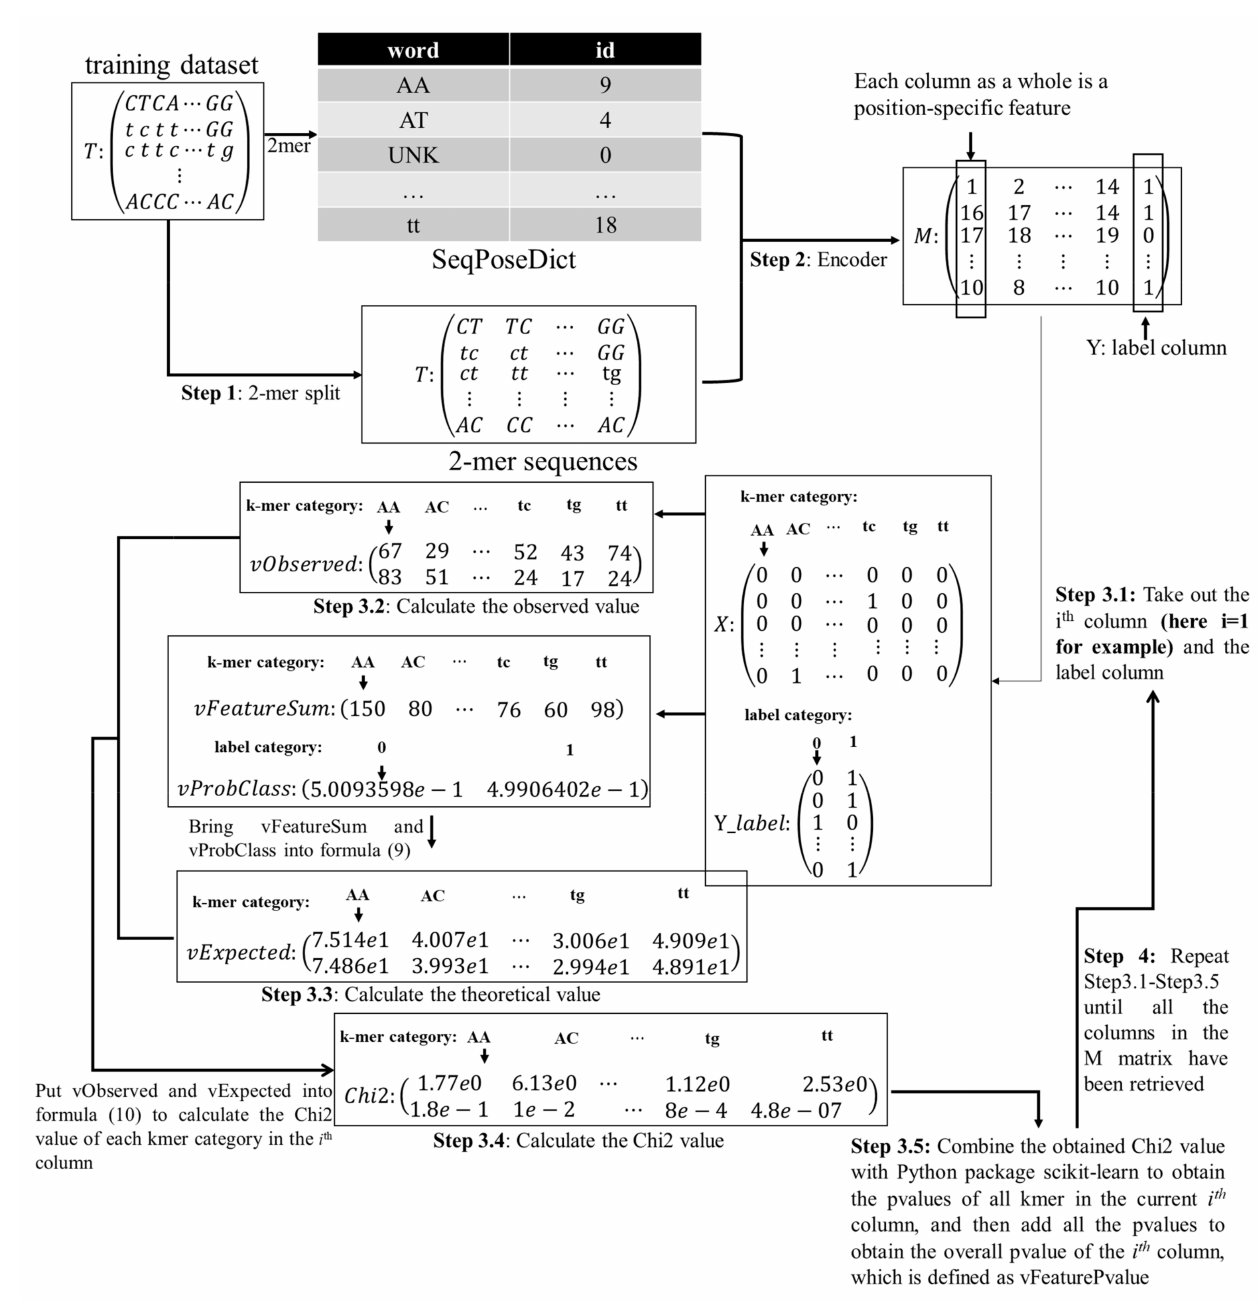
Figure 3. Flow chart of Chi2-based SeqPose feature